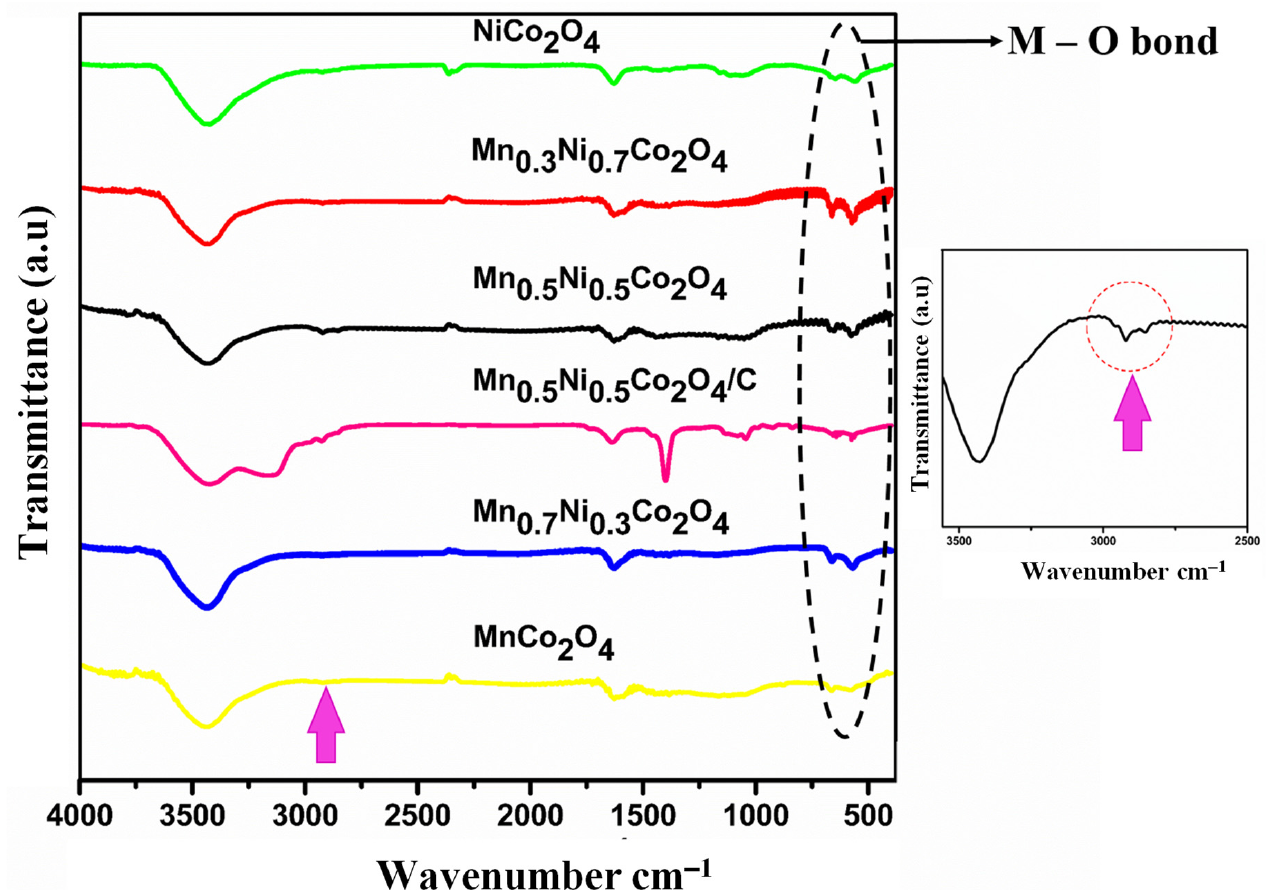
Figure 3. FTIR spectra of Mn x Ni 1 − xCo 2 O 4 spinel oxide series.